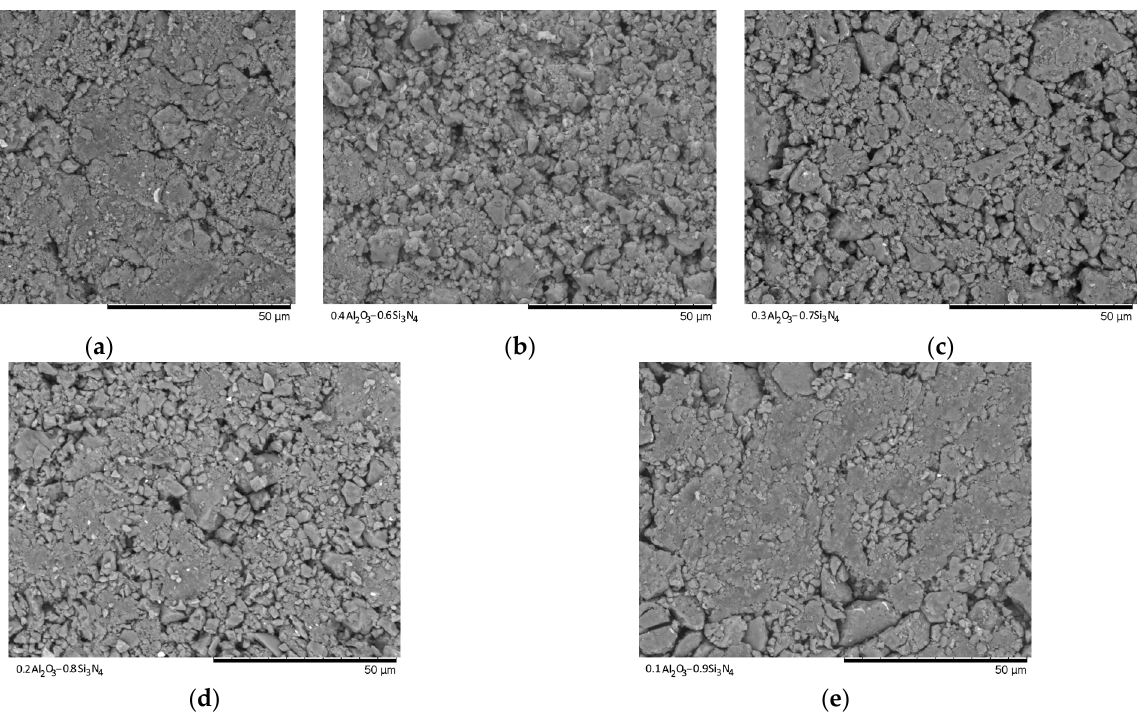
( e ) Figure 10. SEM images of synthesized ceramics in the Backscattered electron image mode: ( a ) 0.5Al 2 O 3 –0.5Si 3 N 4 ; ( b ) 0.4Al 2 O 3 –0.6Si 3 N 4 ; ( c ) 0.3Al 2 O 3 –0.7Si 3 N 4 ; ( d ) 0.2Al 2 O 3 –0.8Si 3 N 4 ; ( e ) 0.1Al 2 O 3 – 0.9Si 3 N 4 . As can be seen from the presented data on the morphological features of the samples after pressing to measure the mechanical strength and resistance to cracking, with a